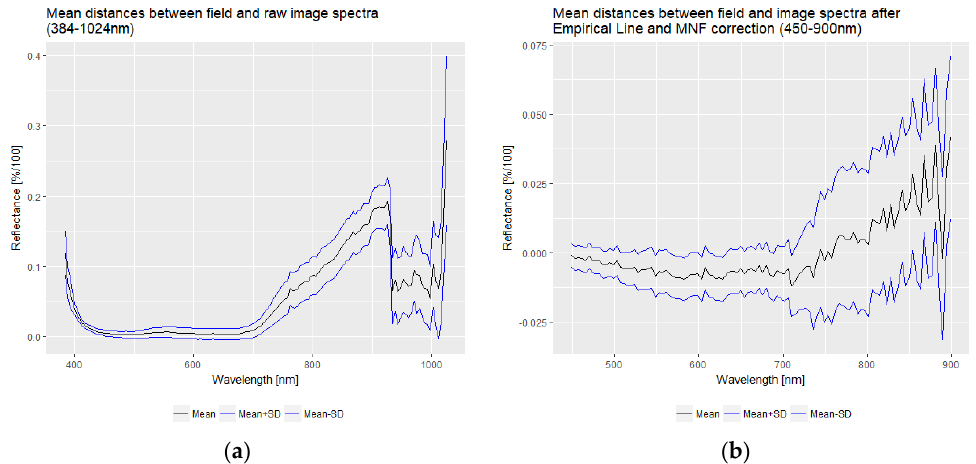
Figure 4. Raw geometry of imagery ( a ) and orthorectified imagery ( b ).